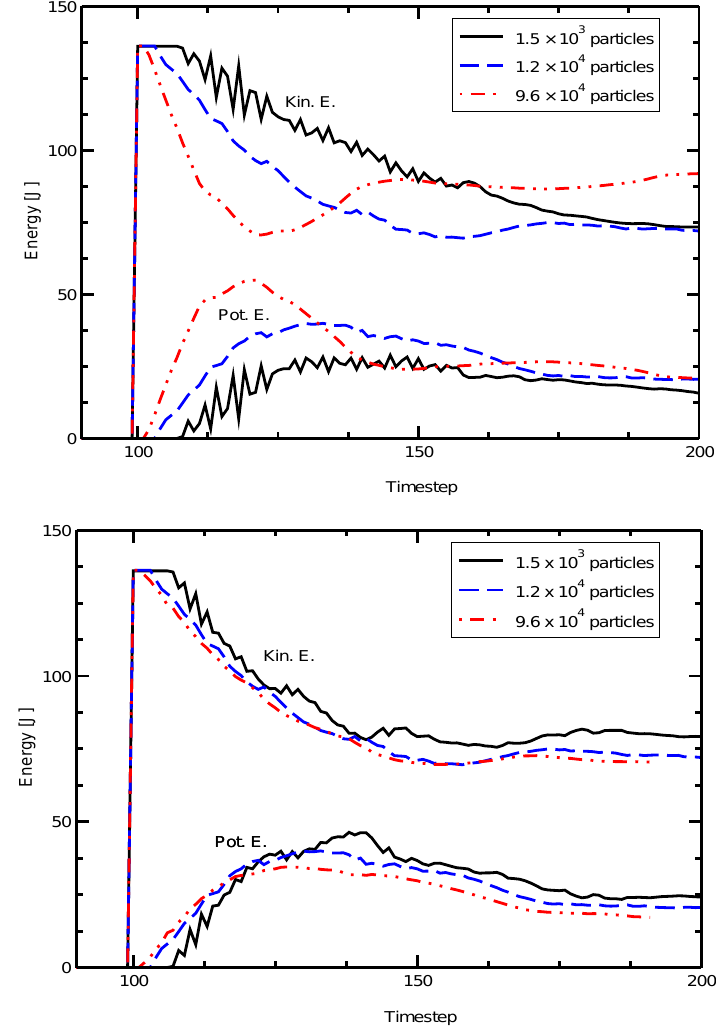
Figure 4. Total potential and kinetic energies of colliding plates with different numbers of particles. ( top ) The unscaled simulation is strongly affected by the number of simulation particles used. ( bottom ) Resizing the simulation renders the resulting energy independent of the number of particles